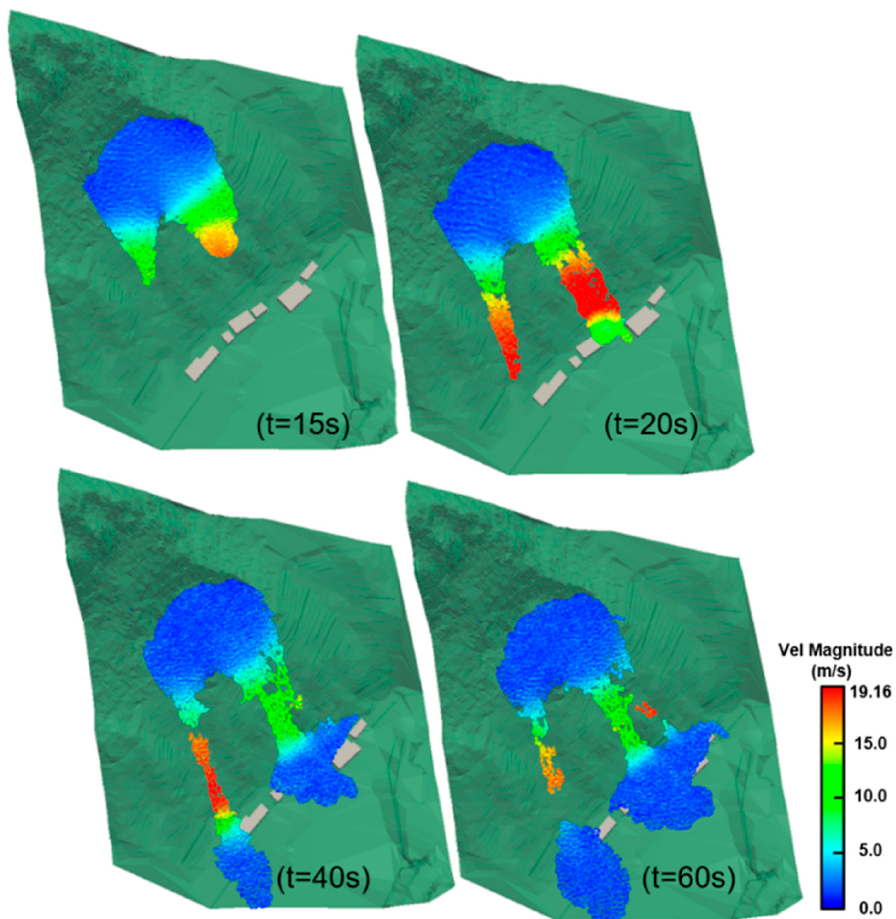
Figure 11. Time-elapsed variation of The Yabakei landslide at different instants.